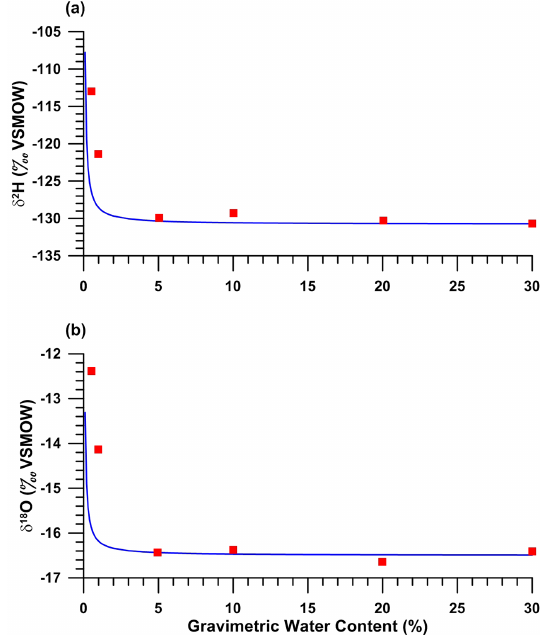
Figure 9. Calculated isotopic equilibrium fractionation of pore wa- ter in a closed system (blue line) compared to data from Wassenaar et al. (2008) measured in the headspace of Ziploc ™ bags for (a) δ 2 H and (b) δ 18